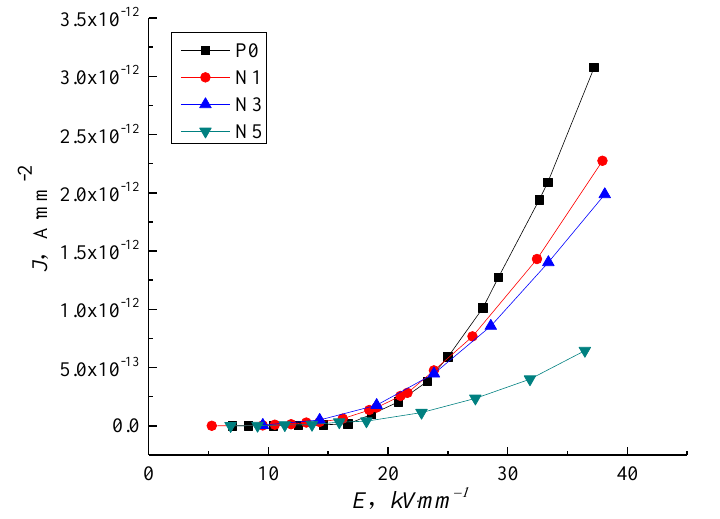
Figure 5. J-E characteristic curve of LDPE and nano-ZnO/LDPE with different content.